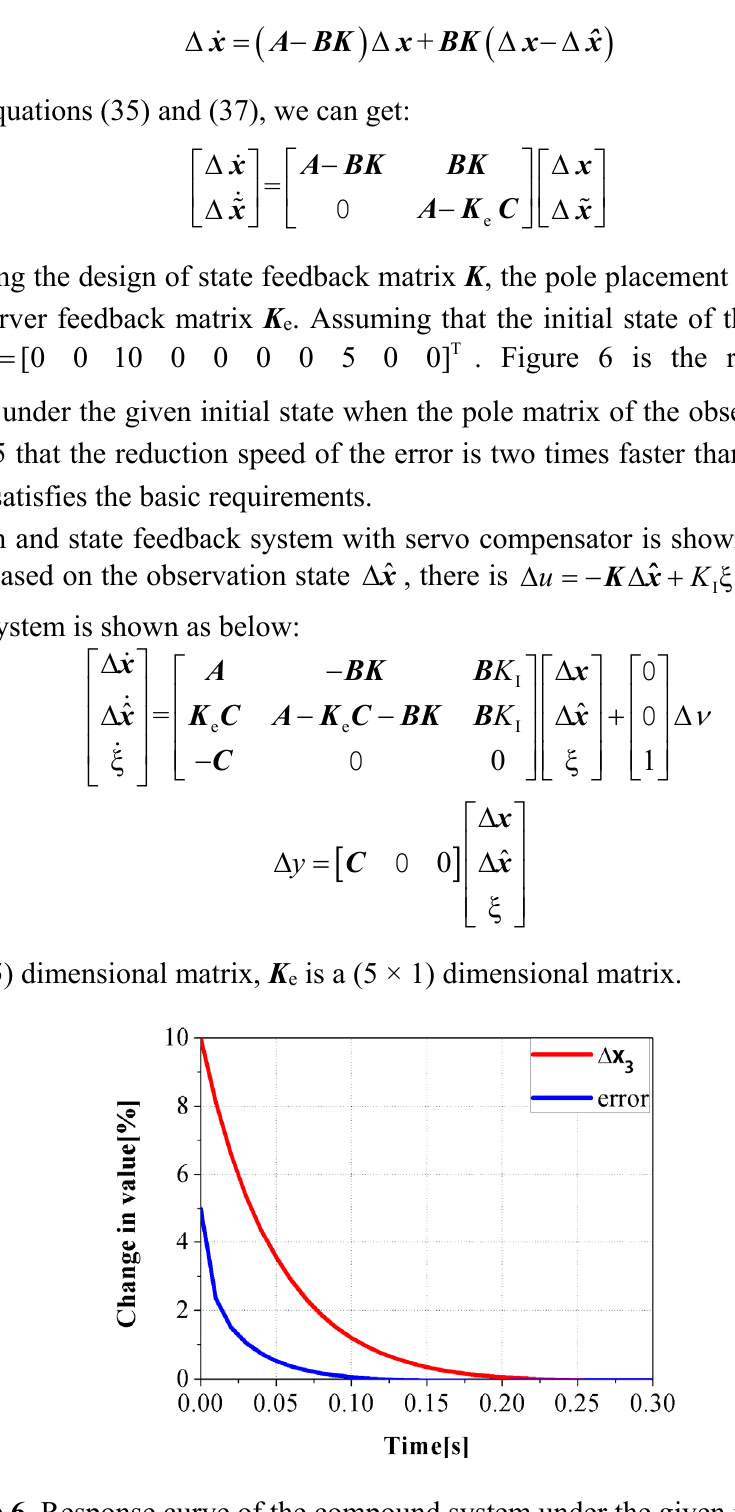
Figure 6. Response curve of the compound system under the given initial